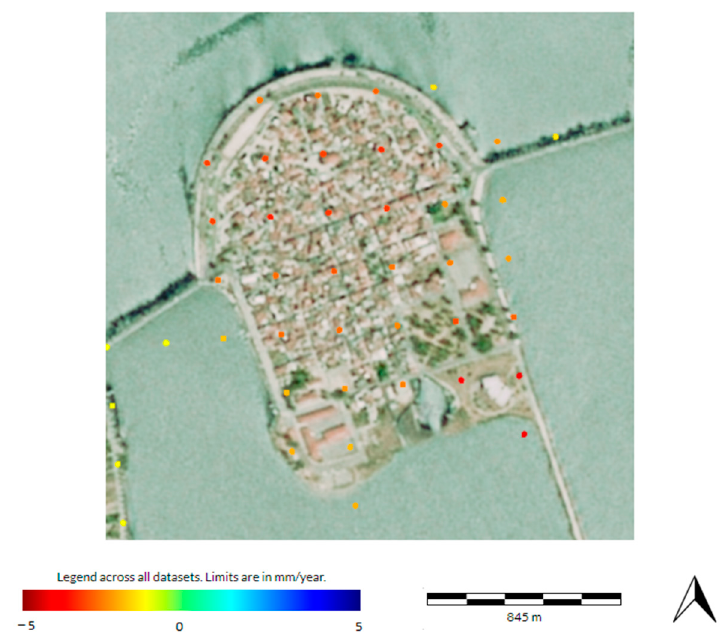
Figure 16. Vertical displacements from the EGMS of Copernicus in Aitolikon.